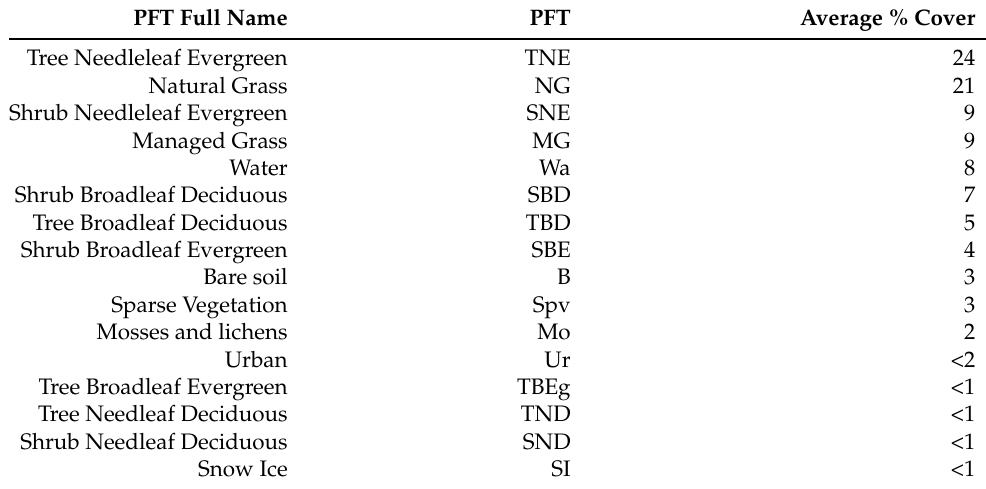
Table A2. Generic PFTs and their average percentage cover over the 69 districts selected and the 1995–2015 period.